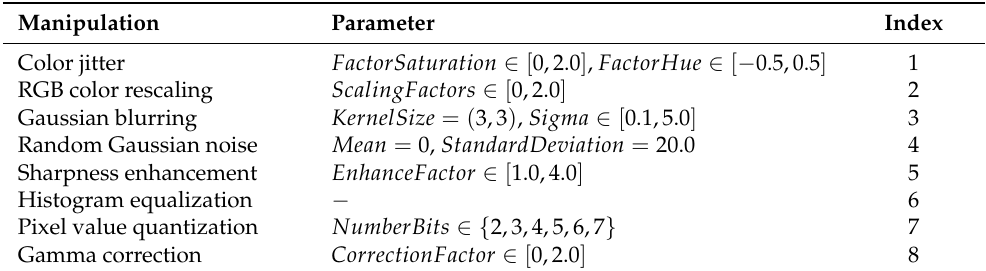
Table 1. Manipulation operations considered in the proposed self-supervised method, the specifi- cations about their parameters, and their indices in the multi-class classification pretext task. The implementation of these manipulations was partially based on